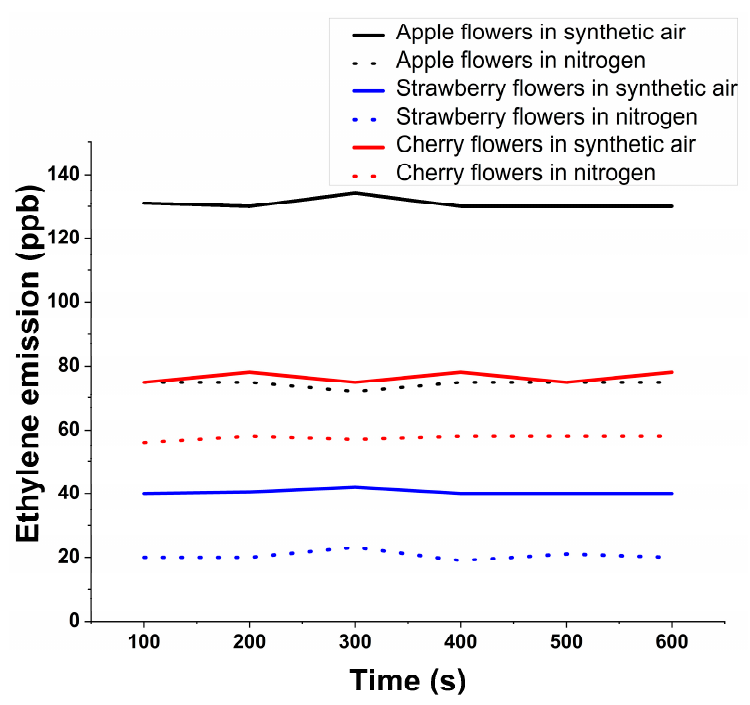
Figure 3. Ethylene evolution for sweet fruits flowers.